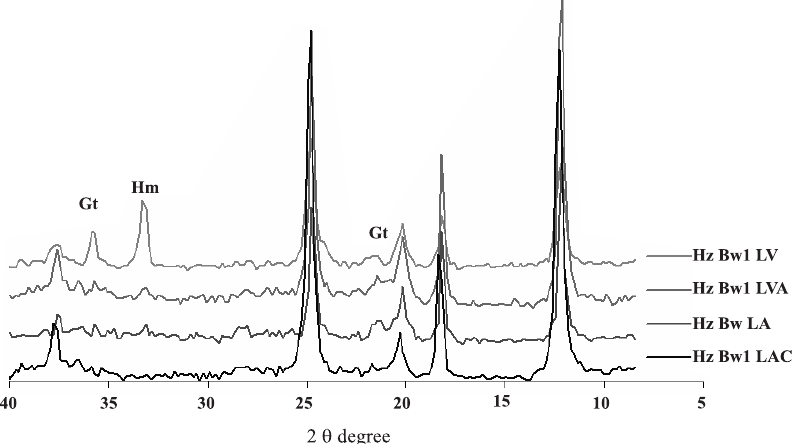
Figure 3. Diffraction obtained by DXRD (total Clay – K25) of the horizon Bw of pedons of the toposequence, where Hm: hematite and Gt: goethite.